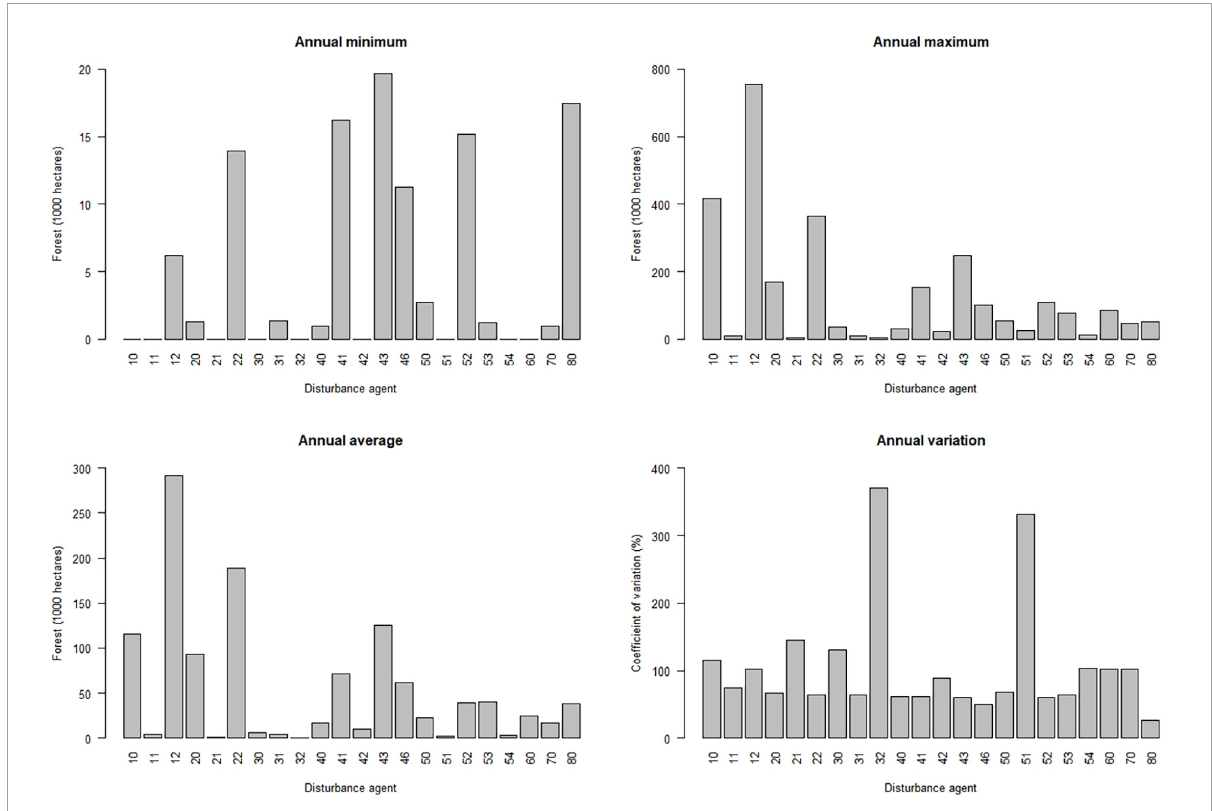
FIGURE3 Summaries of annual disturbance by